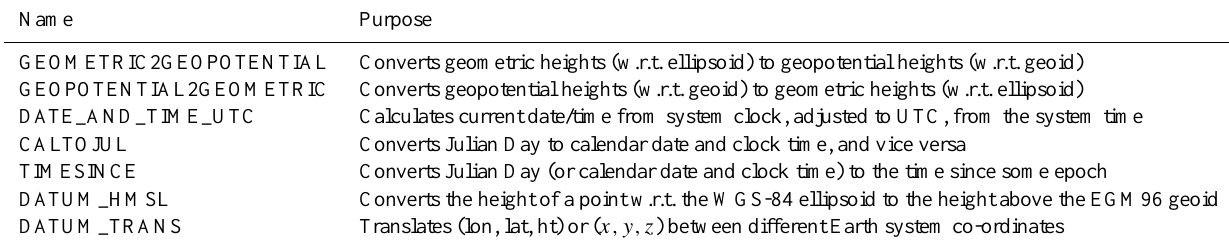
Table 2. Subroutines in the ROPP UTILS module.